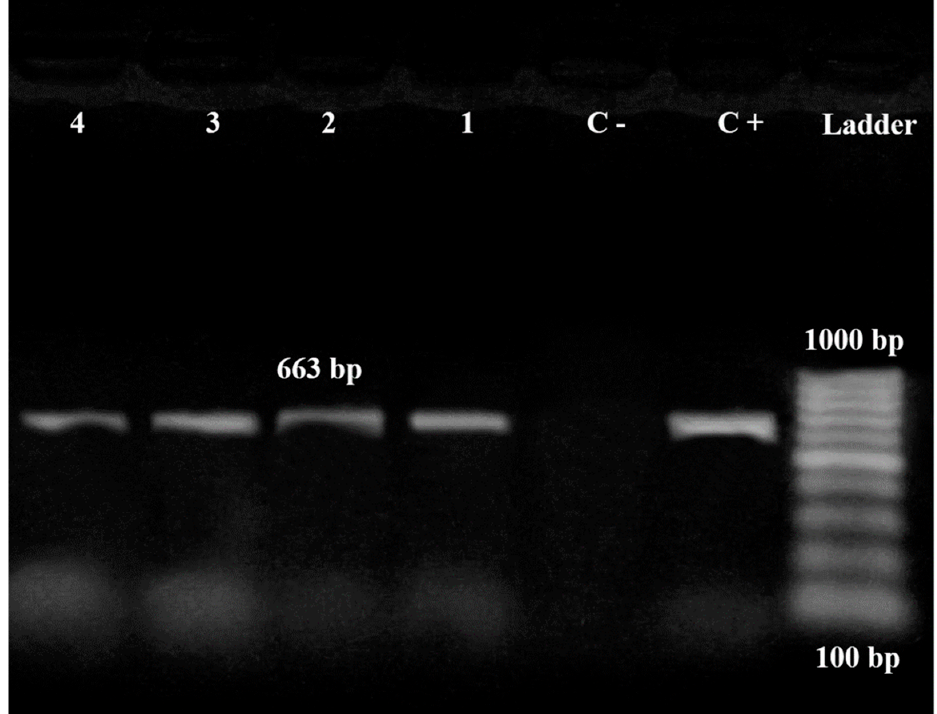
Figure 3. PCR amplification of the 16S rRNA gene of Vibrio spp. Isolated from Litopenaeus vannamei . The PCR products displayed corresponded to the predicted molecular mass of 663-bp (16S rRNA gene). Lane (C+): positive control sample. Lane (C − ): negative control, and to its right is the 100-bp DNA ladder. Lanes (1–4): represent the bacterial DNA samples.